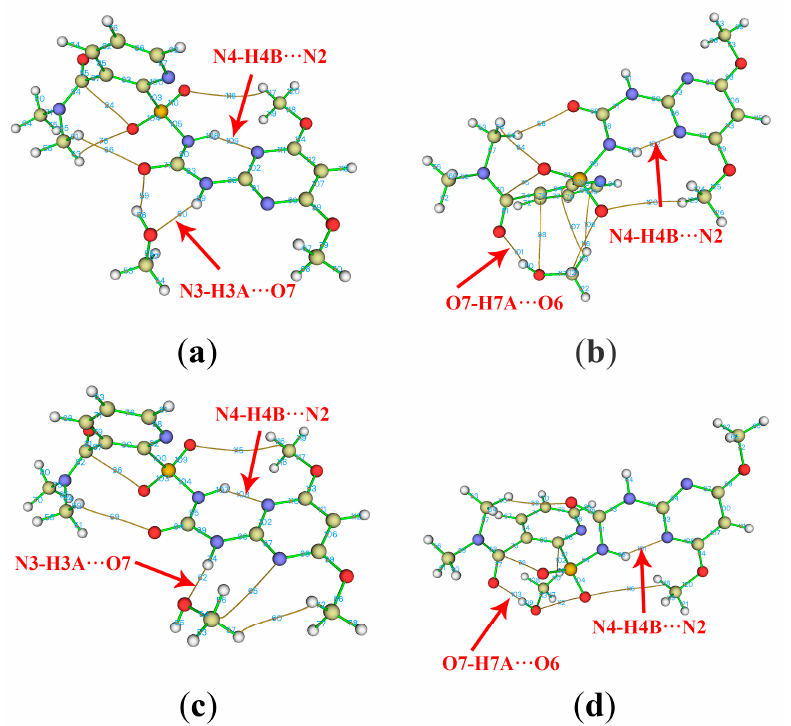
Figure 7. The AIM topological path maps of two NS-methanol pairs in different phases. ( a ) Pair 1 in the gas phase, ( b ) Pair 2 in the gas phase, ( c ) Pair 1 in the liquid phase, and ( d ) Pair 2 in the liquid phase. Small orange dots and thin orange lines indicated the bond critical point, H-bonds among atoms, respectively. H-bonds (N4-H4B···N2, O7-H7A···O6, N3-H3A···O7) were emphatically marked with red arrows, respectively. Table 3. Topological parameters of H-bonds at (3, − 1) BCPs in two NS-methanol pairs in different phases.